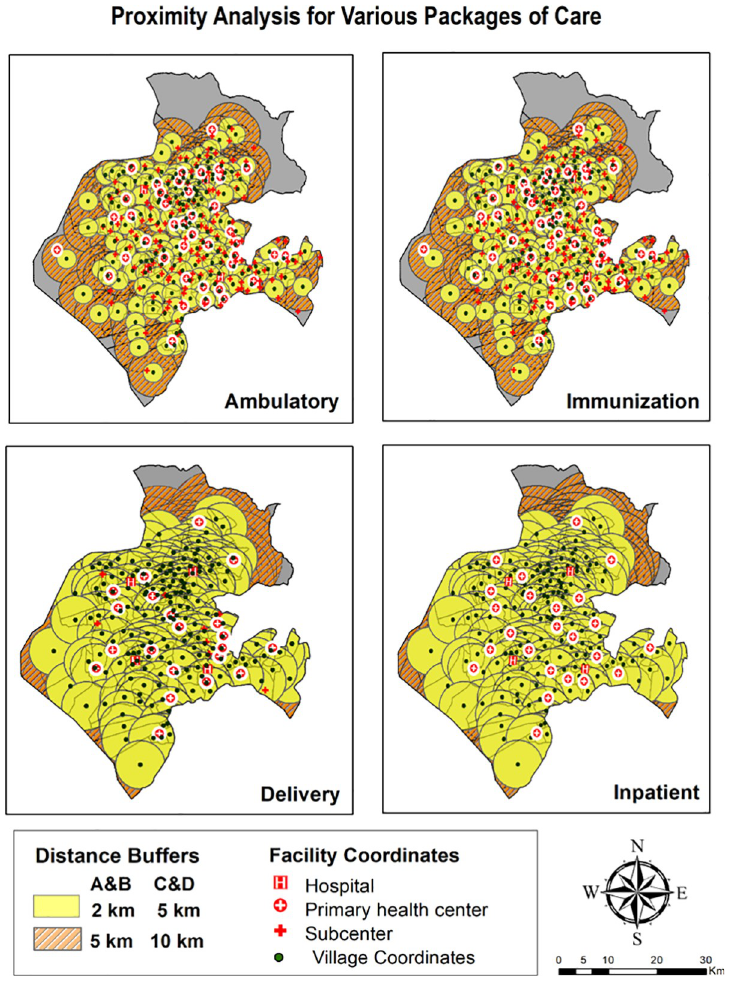
Fig 3. Feature based proximity